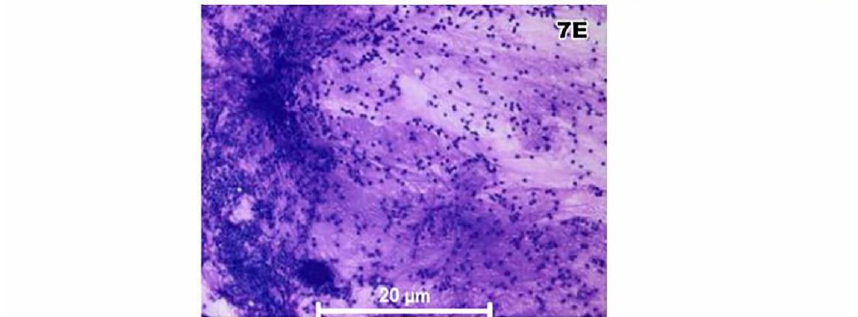
Figure 7. Representative images of the cytological analysis of the conjunctivae under an optical microscope at 400 × magnification. ( A ) Score 0; ( B ) Score 1; ( C ) Score 2; ( D ) Score 3; ( E ) Score 4.